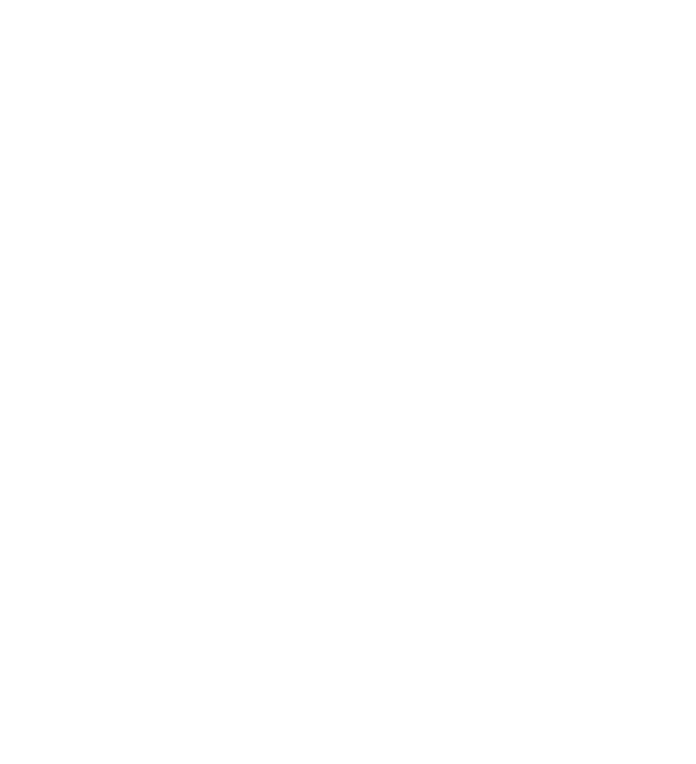
Figure 1. Flowchart of the solid-phase extraction of phospolipids from lipid extract by TiO 2 µ